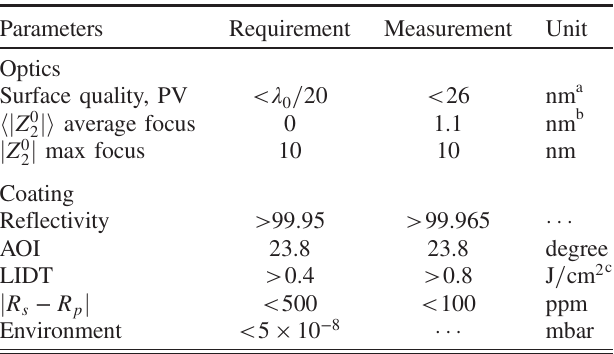
TABLE IV. Measured and specified optical properties of the MPS